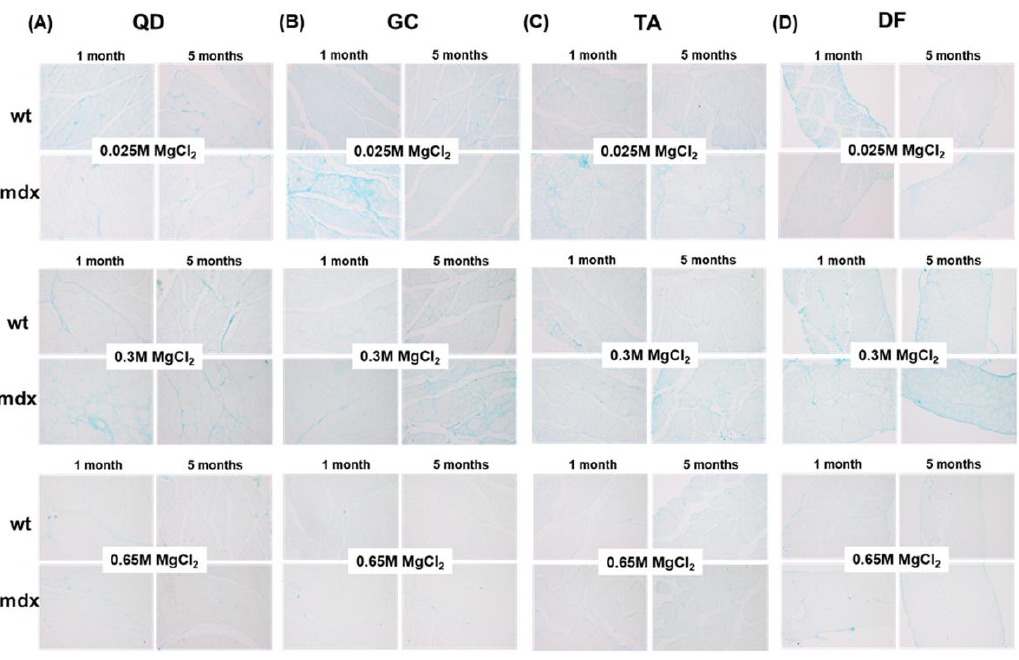
Figure 6. Representative micrographs of skeletal muscle sections stained with Alcian blue containing different MgCl 2 concentrations to specifically stain and differentiate total (0.025 M), sulphated (0.3 M), or highly sulphated (0.65 M) GAG/PG content. Original magnification: 20×.